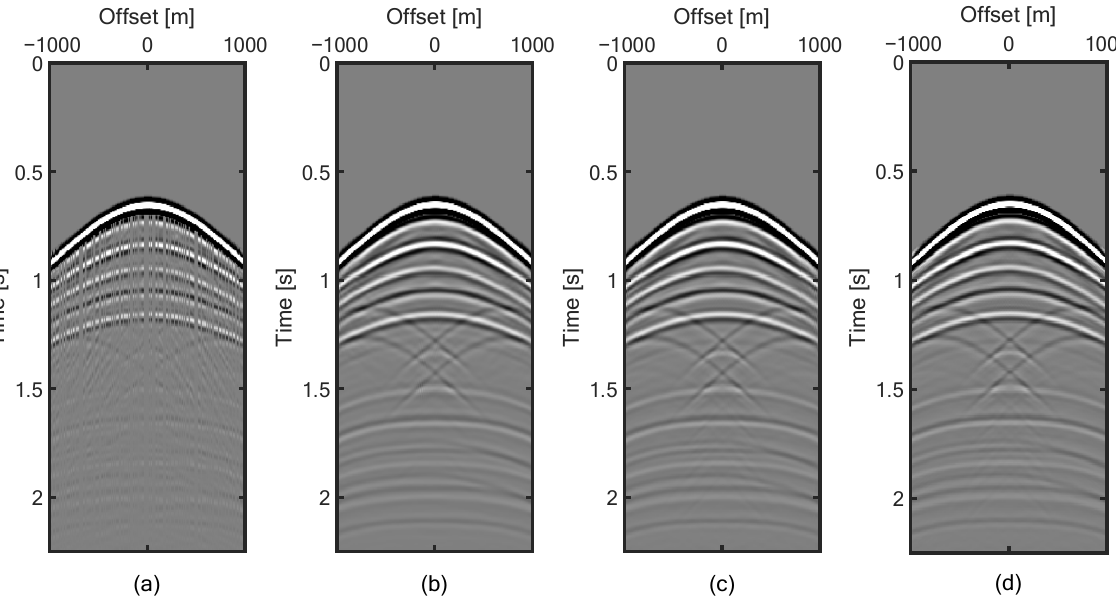
Figure 11. Comparison of Green’s functions. ( a ) is obtained using the standard Marchenko method with irregular sampling; ( b ) is obtained using sparse reconstruction with SPGL1 solver; ( c ) is obtained using sparse reconstruction with FISTA solver, and ( d ) is the reference Green’s function.